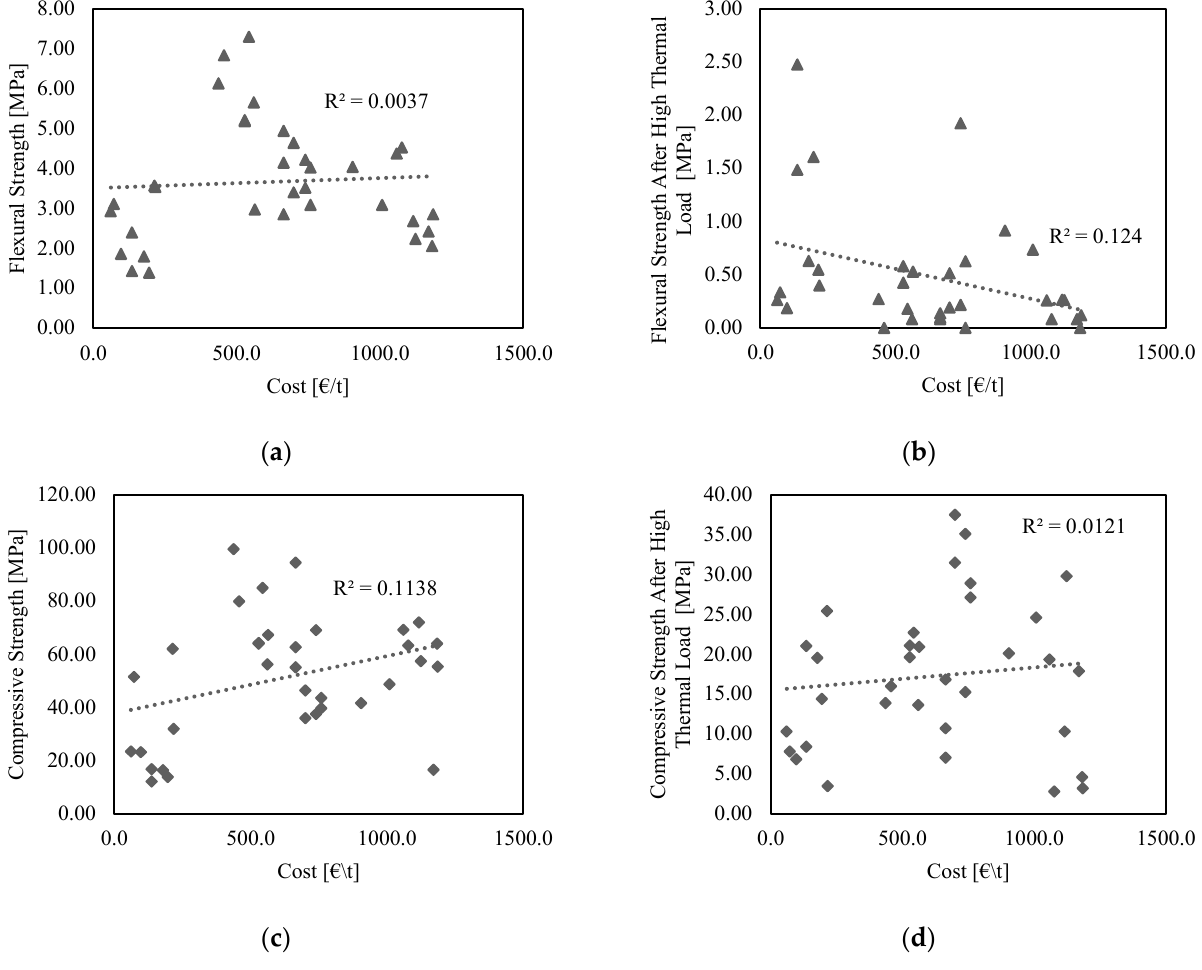
Figure 10. Correlation between cost and: ( a ) unheated flexural strength; ( b ) flexural strength after a high thermal load; ( c ) unheated compressive strength; ( d ) compressive strength after a high thermal load. For all samples, the water-to-binder ratio equals 0.176, and the tests occurred after 42 days of curing in ambient conditions, preventing moisture loss.